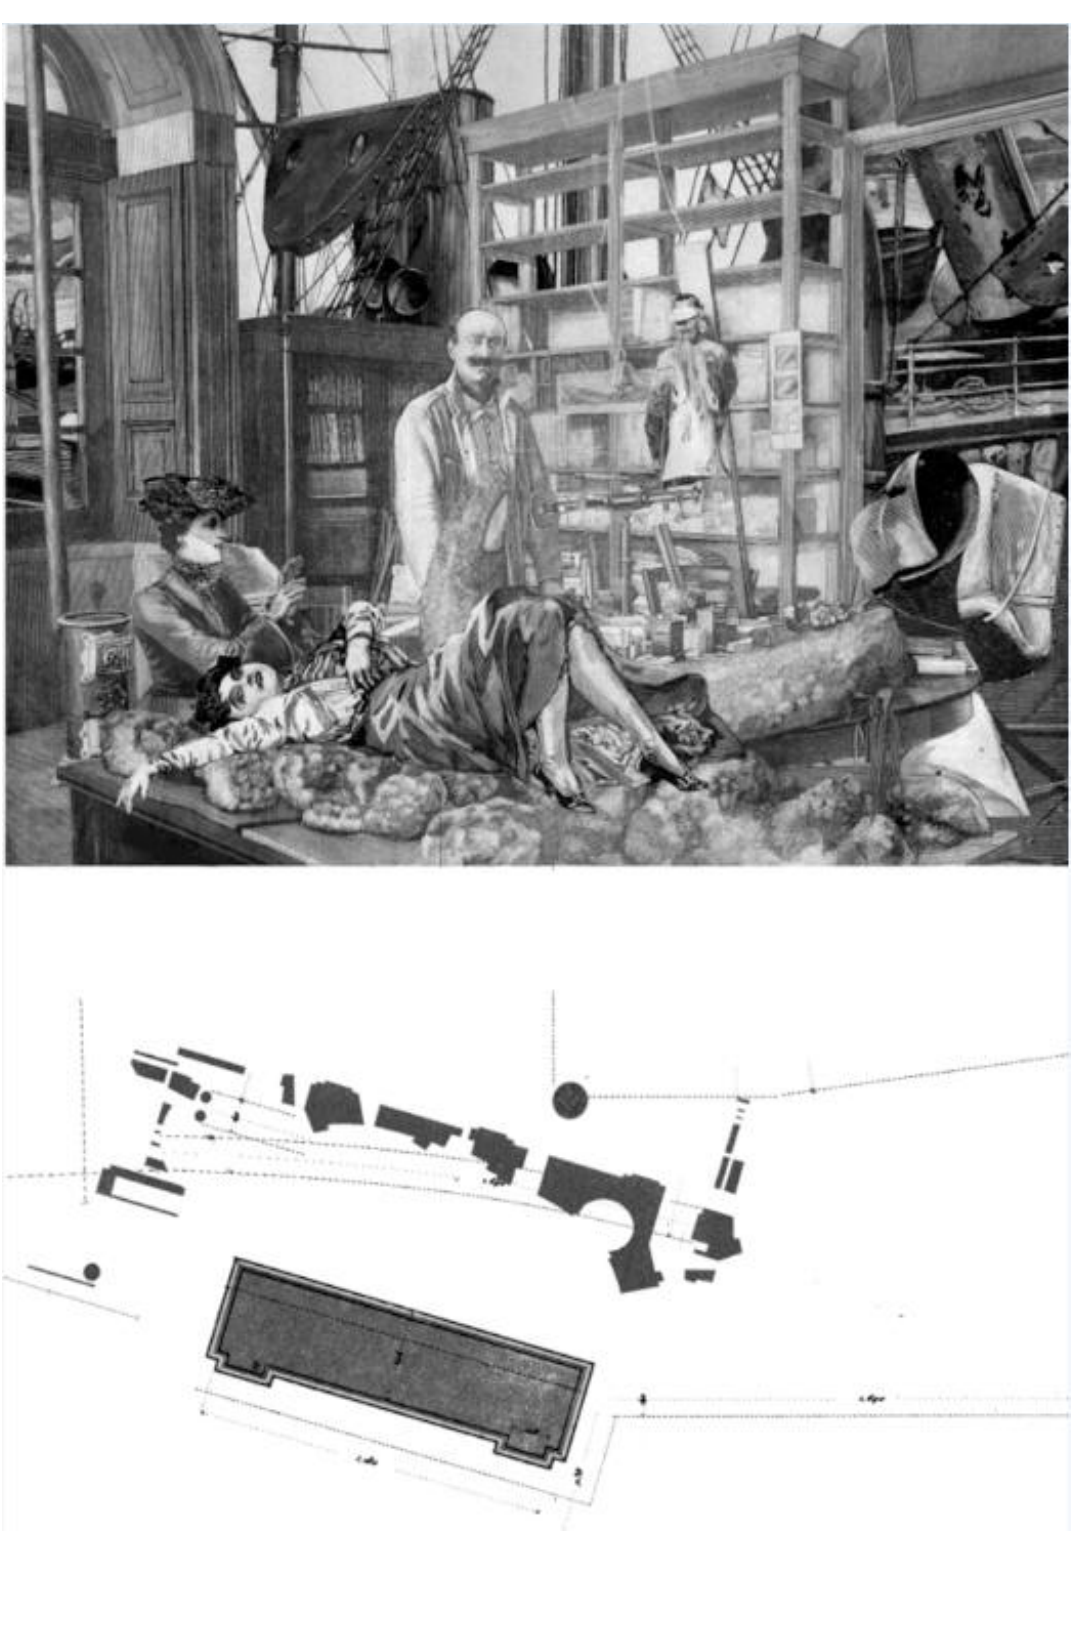
Figure 5. Paper Collage, comprised of original engravings from La Grande Illustré (1904): Of a Shipwreck’s Depth